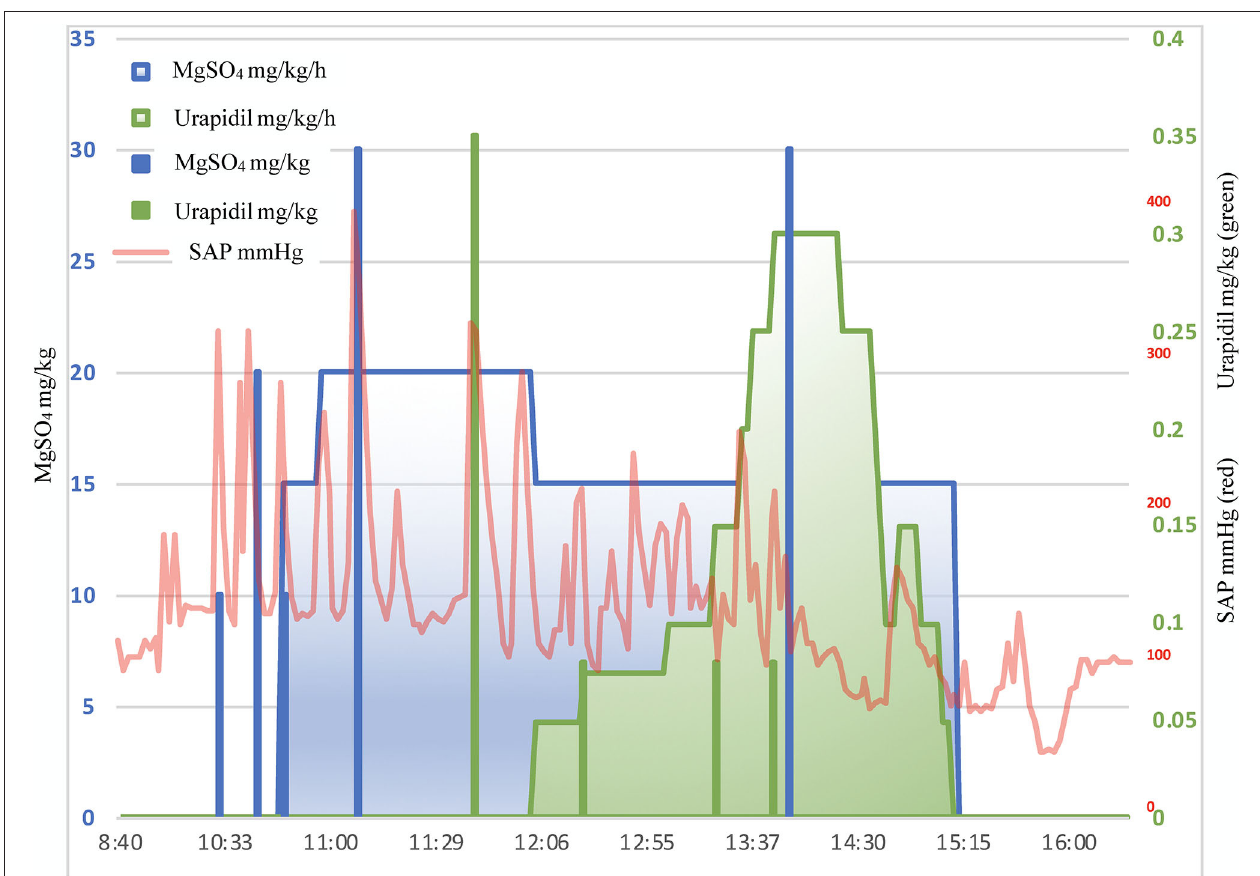
FIGURE 2 | Graphical representation of MgSO 4 (blue) and urapidil (green) administration plotted against SAP (red) over time.